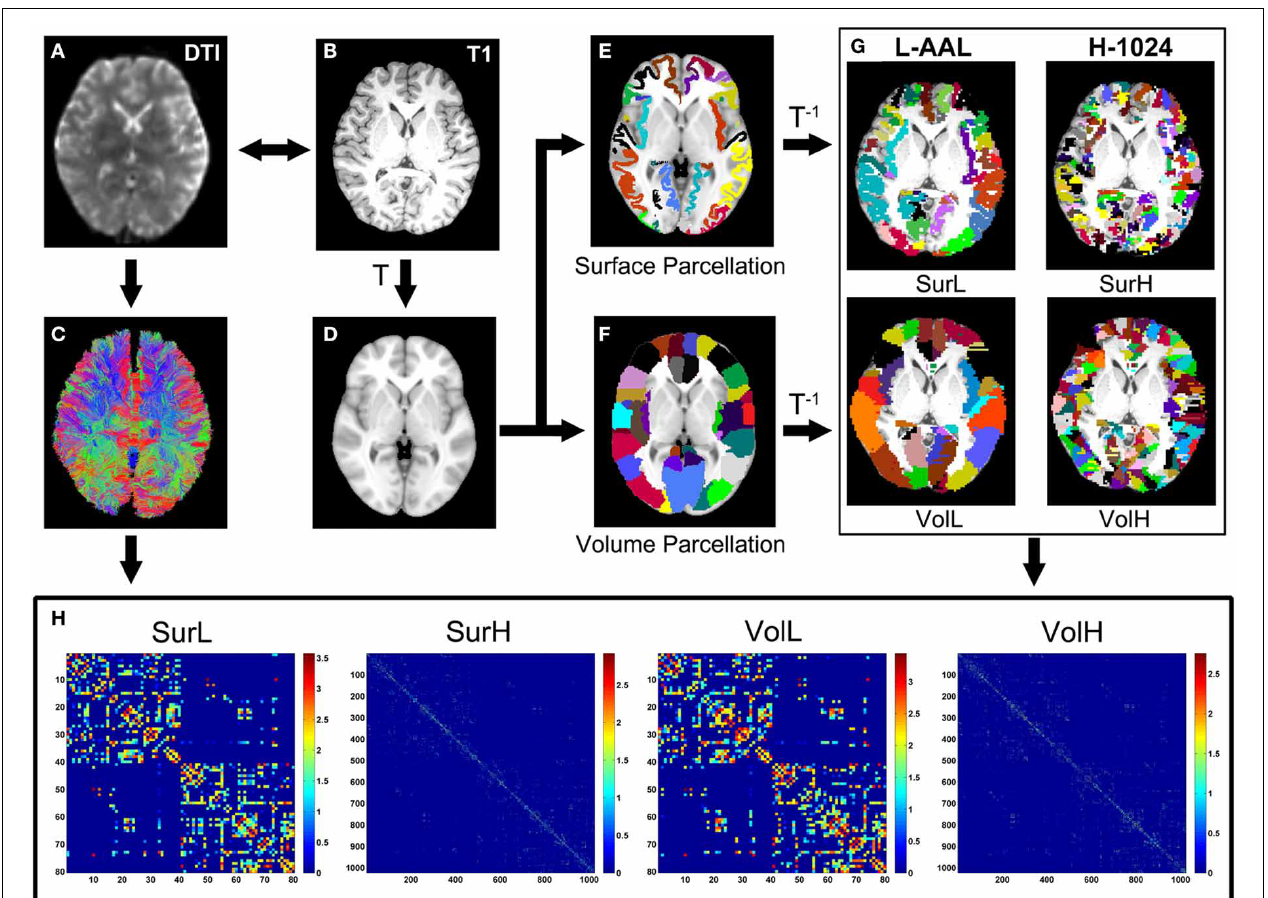
FIGURE 1 | The flowchart of the construction of four WM networks under two parcellation methods and two resolutions. (1) The b = 0 image (A) and the individual T1-weighted image (B) were coregistered through a linear transformation. (2) The T1 images were then nonlinearly normalized to the ICBM152 T1 template (D) in the MNI space. (3) Each vertex on the average cortical surface of 150 normal brains was assigned with the value of the label in the volumetric AAL (F) to generate an atlas of surface parcellation (E) . (4) The inverse transformations were used to warp the AAL atlas to the native diffusion space. (5) Both surface and volume atlases were